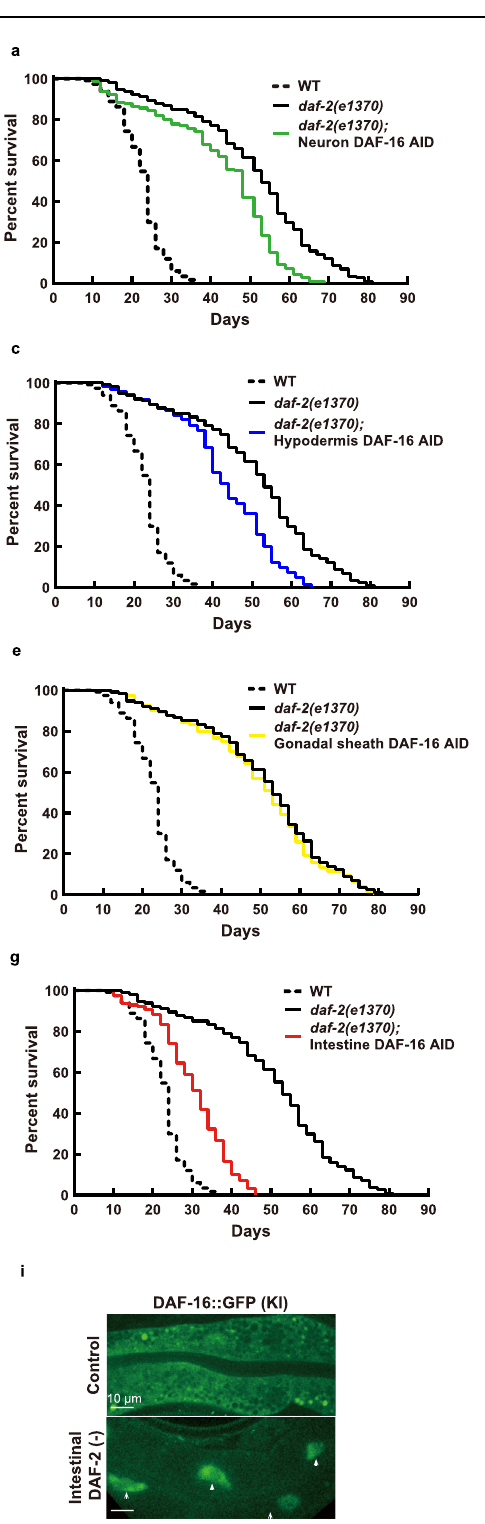
Fig. 4 | Intestinal DAF-16 mediates daf-2(e1370) longevity. a Degrading DAF-16 from the neurons shortened the daf-2(e1370) lifespan by 15.6% ( p <0.0001). b DegradingDAF-16fromthegermlinehadnosigni fi canteffectonthe daf-2(e1370) lifespan ( p =0.347). c Degrading DAF-16 from the hypodermis shortened the daf- 2(e1370) lifespan by 15.6% ( p <0.0001). Degrading DAF-16 in the body wall muscle ( d ),gonadalsheath( e ),orXXXcells( f )hadnoeffectonthelifespanof daf-2(e1370) ( p >0.05). g Degrading intestinal DAF-16 shortened the daf-2(e1370) lifespan by 40.1% ( p <0.0001). h Degrading DAF-16 in all tissues shortened the daf-2(e1370)